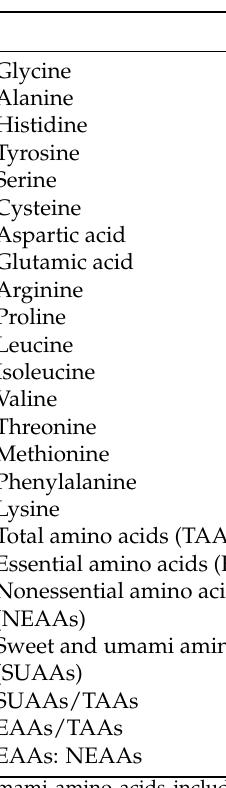
Figure 1. Changes of TVB-N in shrimp head during autolysis.